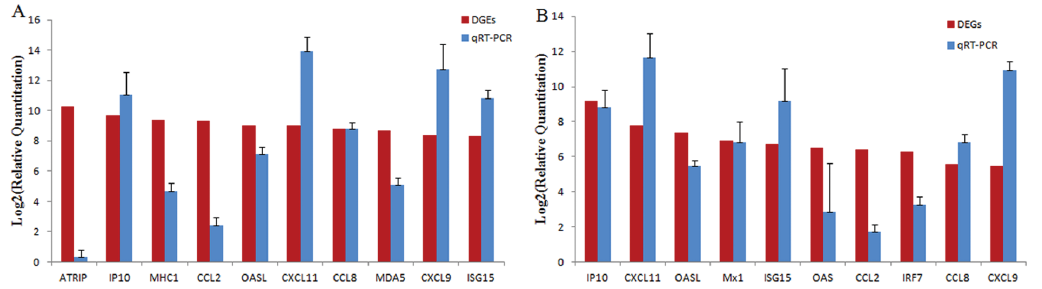
Figure 5. Confirmation of the most upregulated genes by qRT-PCR. ( A ) In the EV71-infected group, 10 of the most upregulated genes were selected and analyzed: ATRIP, IP10, MHC1, CCL2, OASL, CXCL11, CCL8, MDA5, CXCL9, and ISG15. ( B ) In the CVA16-infected group, IP10, CXCL11, OASL, Mx1, ISG15, OAS, CCL2, IRF7, CCL8, and CXCL9 were selected and